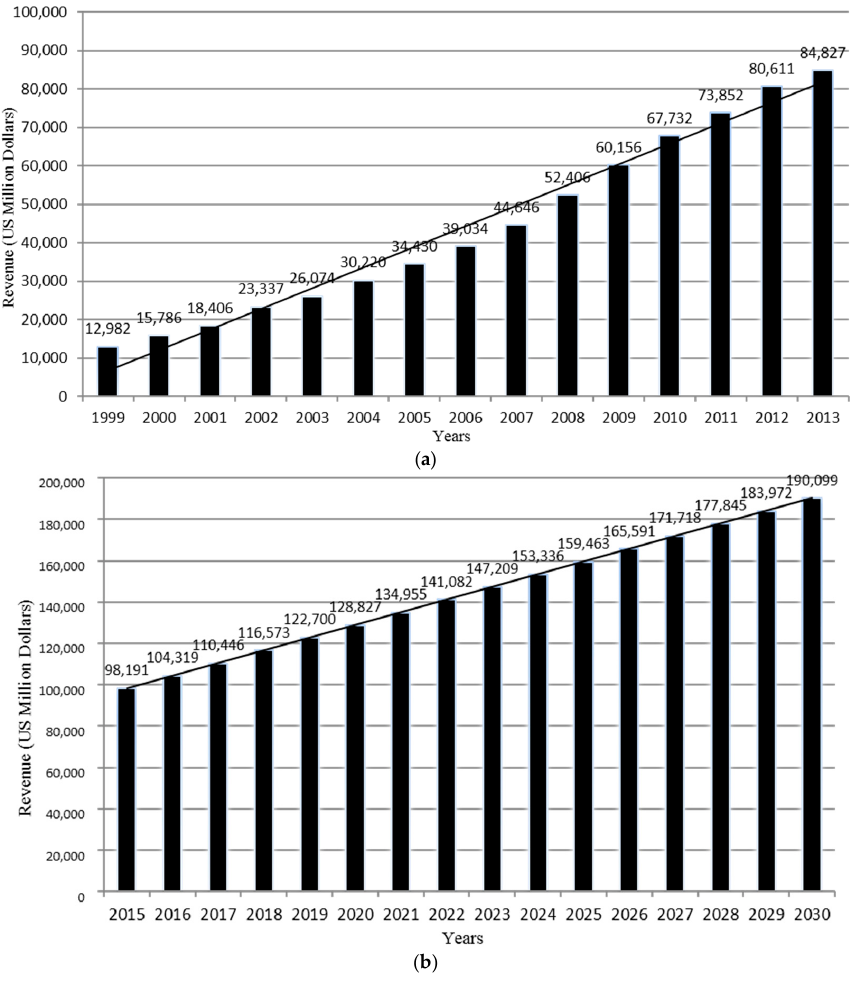
Figure 1. Trends in fast food (FF) industry revenue growth and future projection in China between 1999 and 2030. ( a ) Observed FF industry revenue growth in China between 1999–2013 adjusted for the inflated by Consumer Price Index, 2010 = 100); ( b ) Projected FF industry revenue growth in China between 2015–2030. Table 1. Key statistics and growth of the fast food industry in China: observed for 2004–2012.